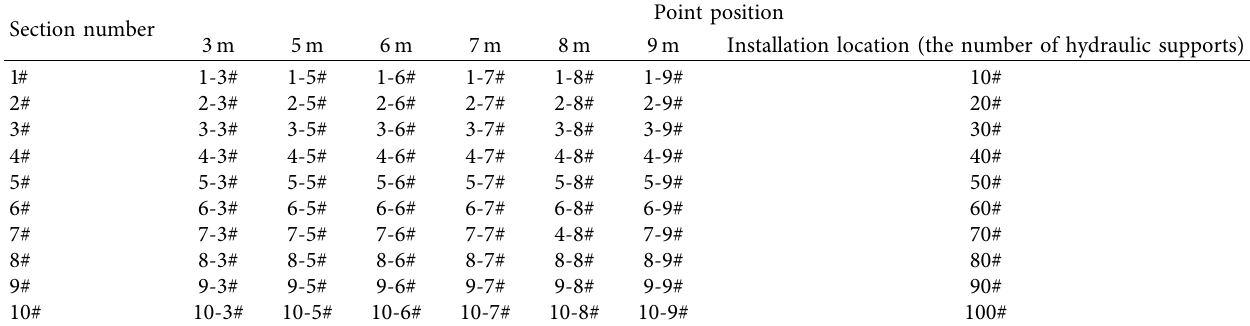
Table 3: Distribution of measuring points on different monitored sections.